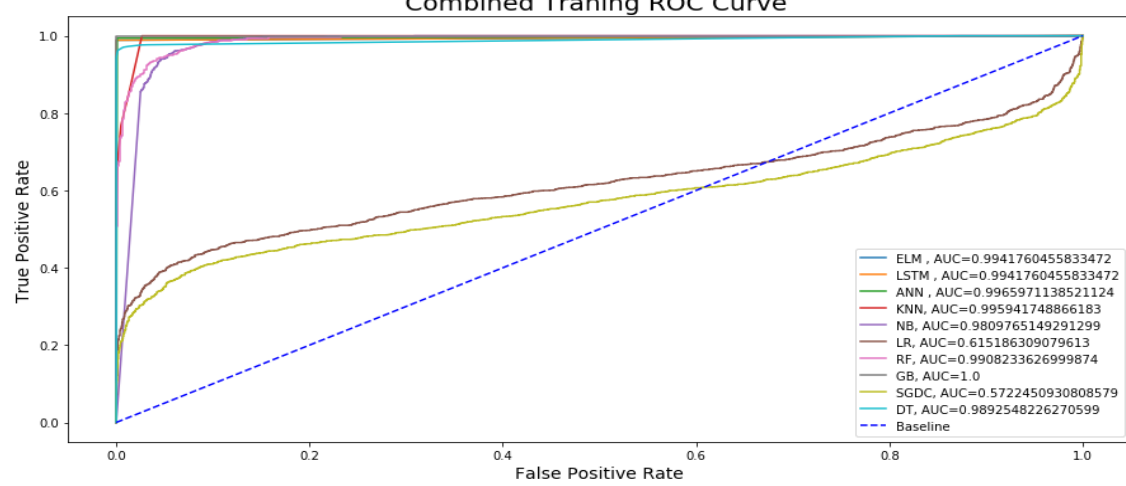
Figure 13. ROC Curve for Training Comparison of Epileptic Activities.